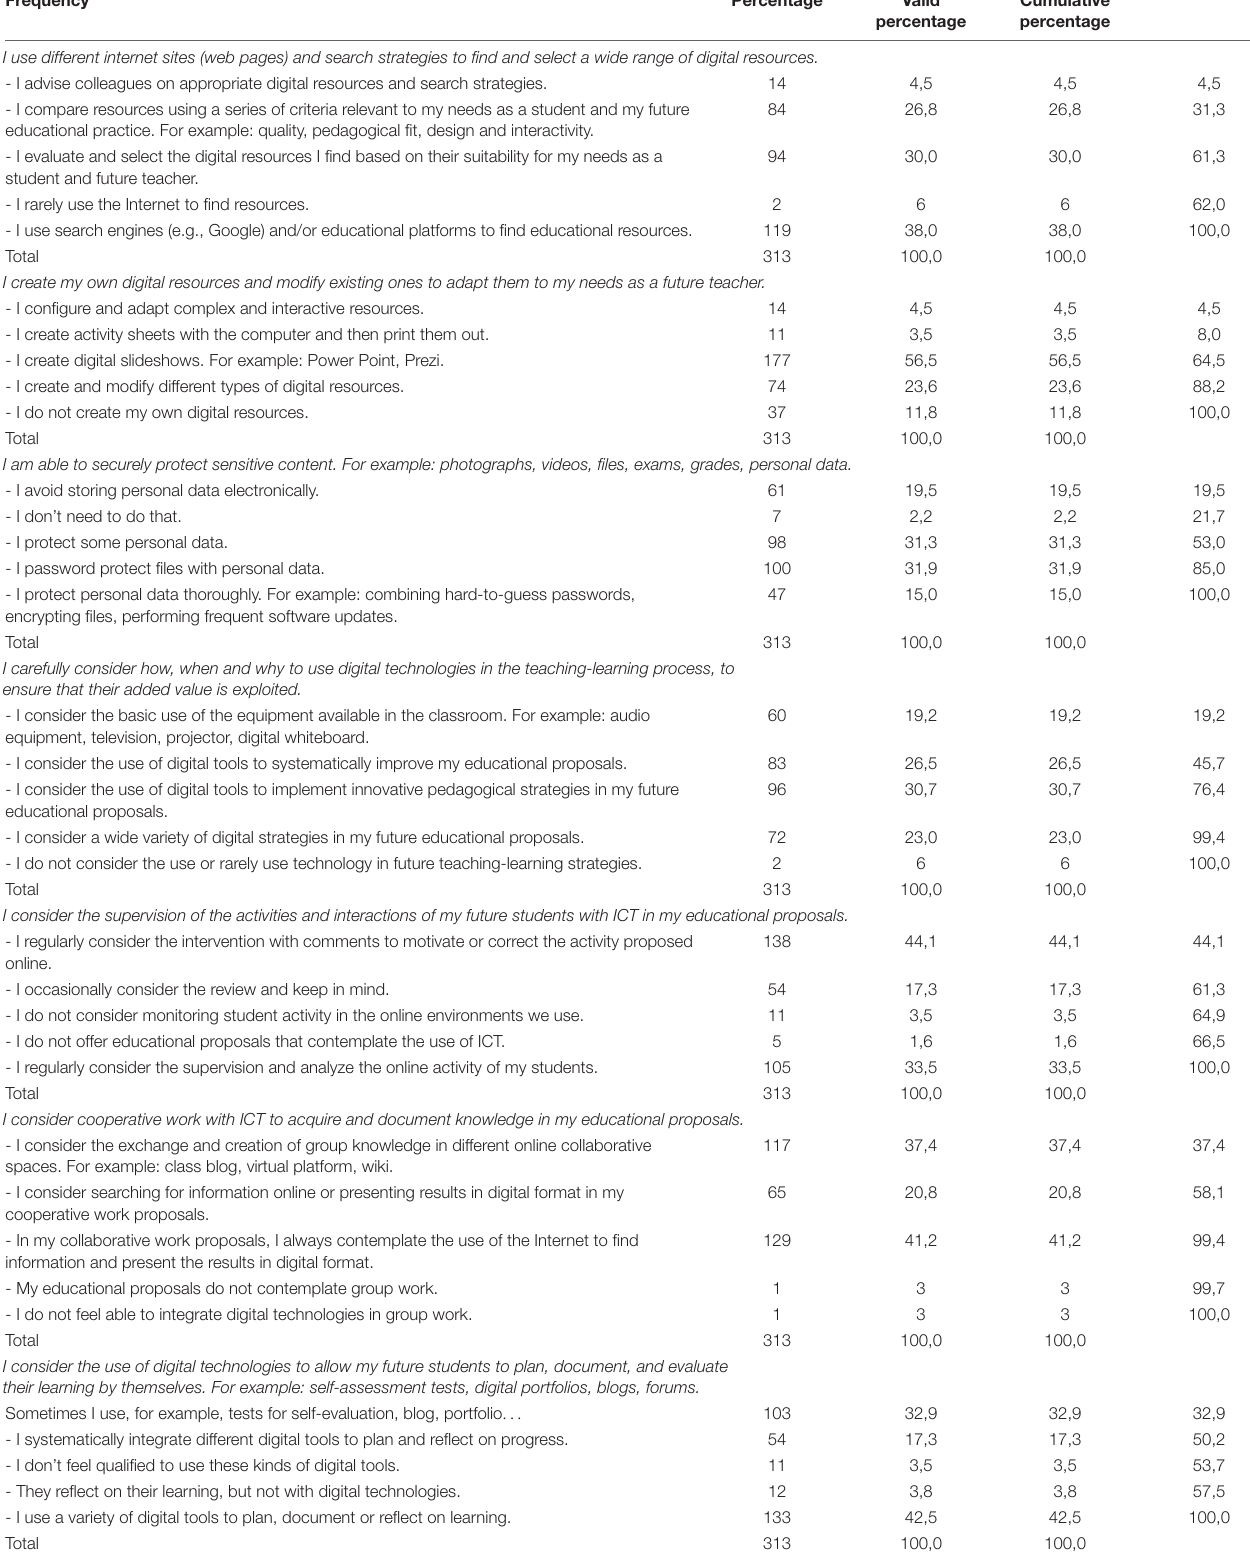
TABLE 3 | Digital teaching competence questionnaire check-in item results (response percentage). Frequency Percentage Valid